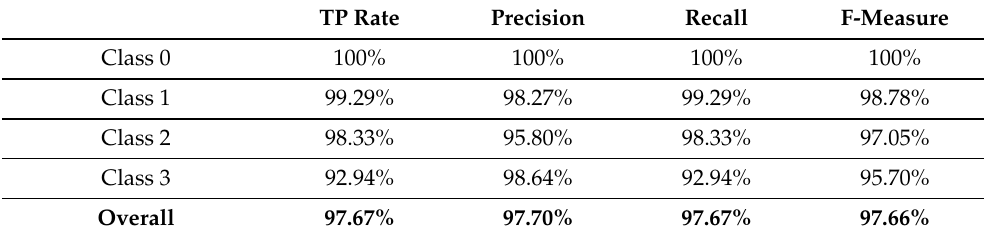
Table 7. The classification TP rate, precision, recall and F1-score of the high-resolution frames on the test set.